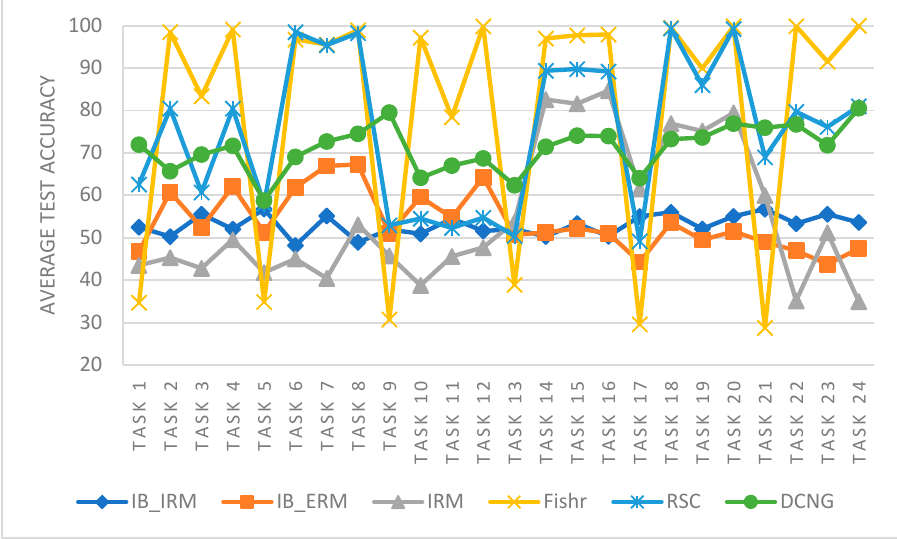
Figure 8. Performance comparison of different generalization methods on KAT data sets.